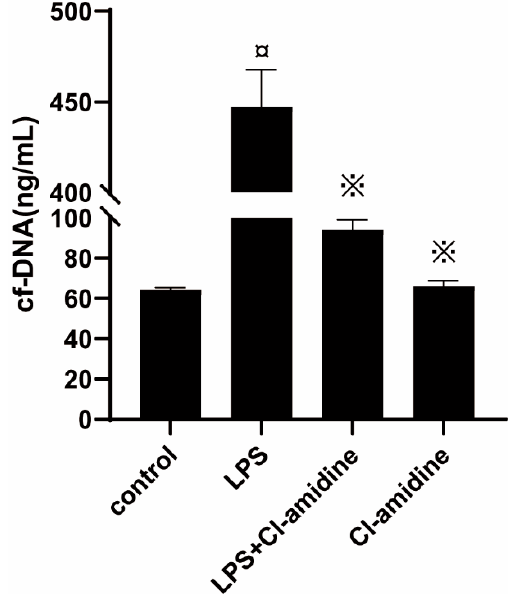
Figure 5. Quantification of extracellular DNA in the plasma of rats with LPS-induced endometritis with Cl-amidine treatment. Data were represented by mean ± SD ( n = 5 animals per group). ¤ p < 0.05 vs. control rats and ※ p < 0.05 vs. LPS without Cl-amidine.